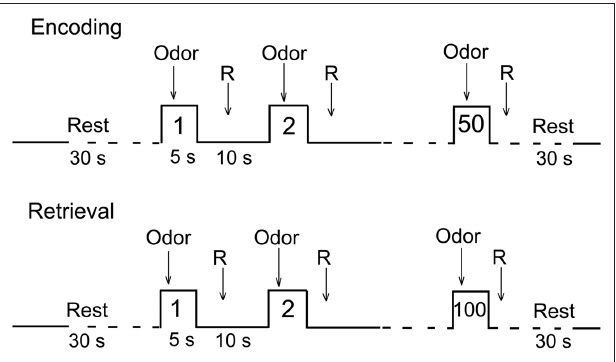
FIguRe 1 | experimental procedure.